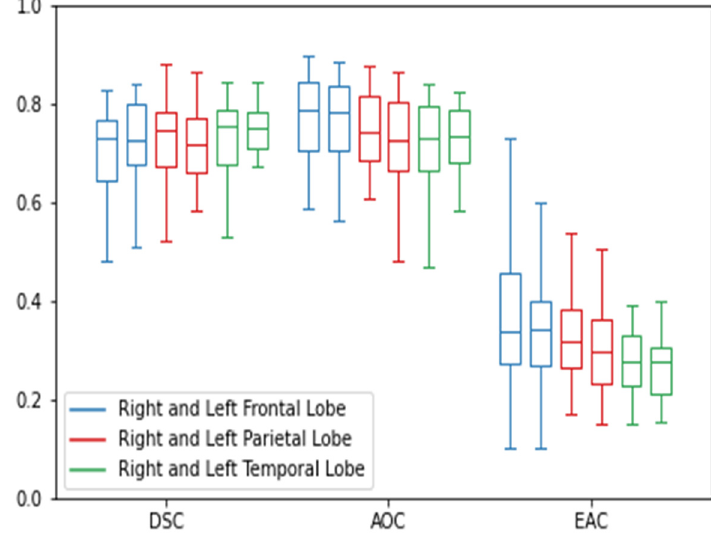
Figure 5. U-Net3D results of DSC , AOC , and EAC indices on test dataset .